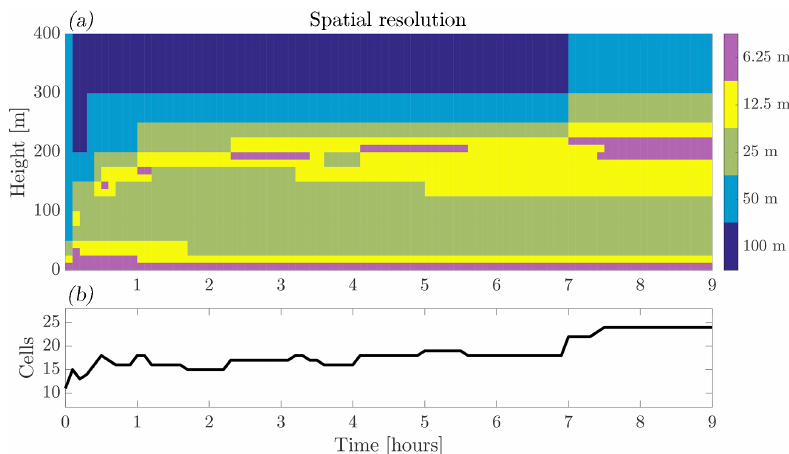
Figure 5. Evolution of (a) the vertical spatial-resolution distribution and (b) the total number of grid cells for the GABLS1 inter-comparison